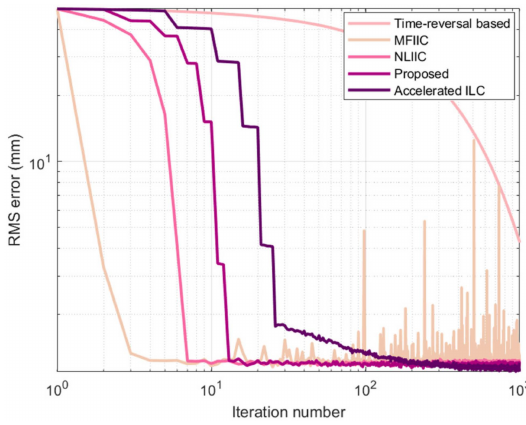
Figure 8. Error curve of iterative learning process.